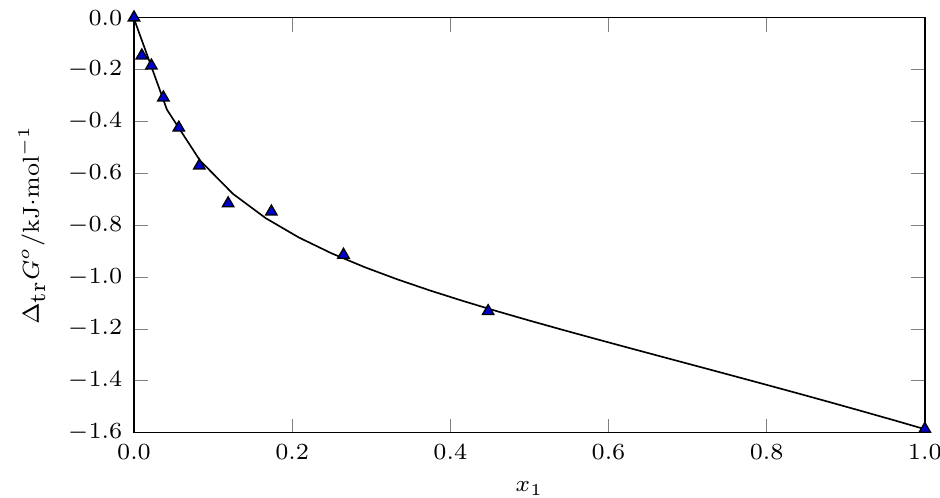
Figure 13. Gibbs energy of transfer of isoniazid (3) from neat water to (PEG 200 (1) + water (2)) cosolvent mixtures at T = 298.15